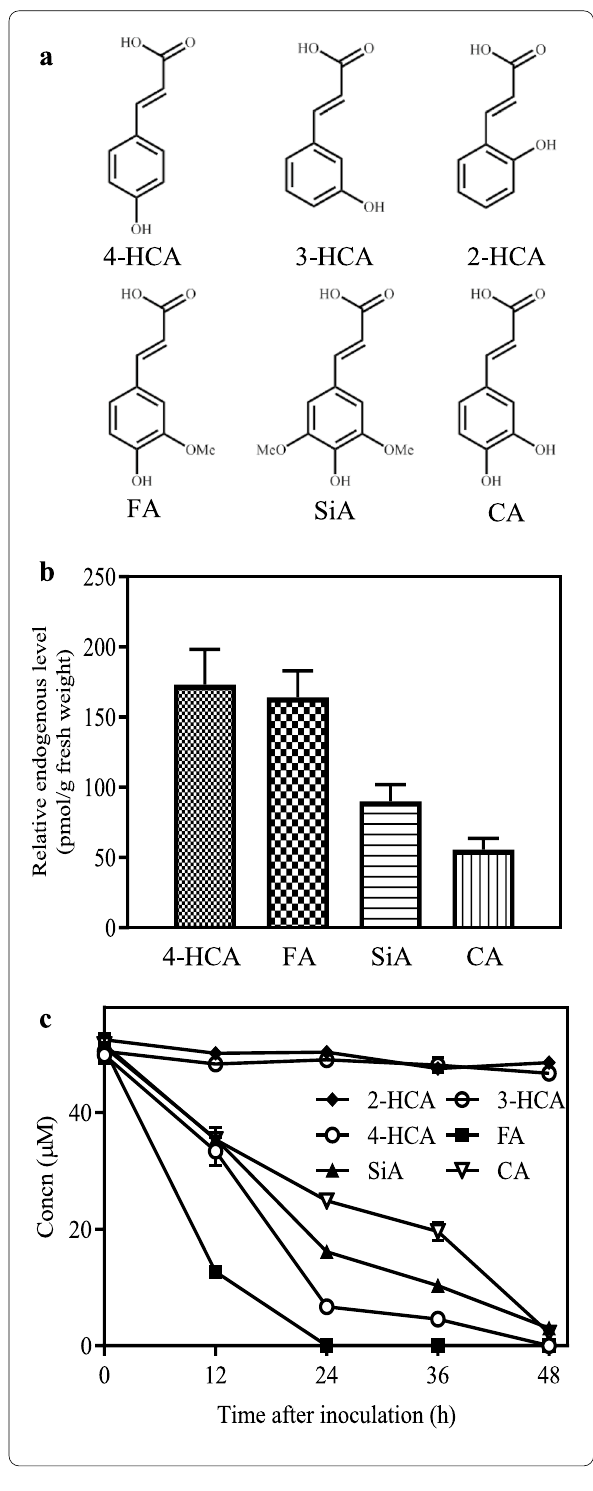
Fig. 1 Hydroxycinnamic acid degradation by strain XC1 of Xcc